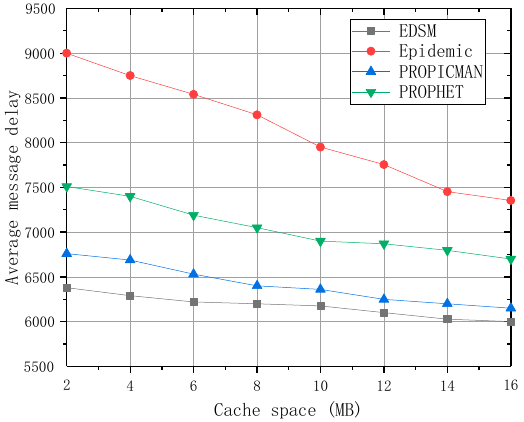
Figure 7. Message delivery success rate in different cache.